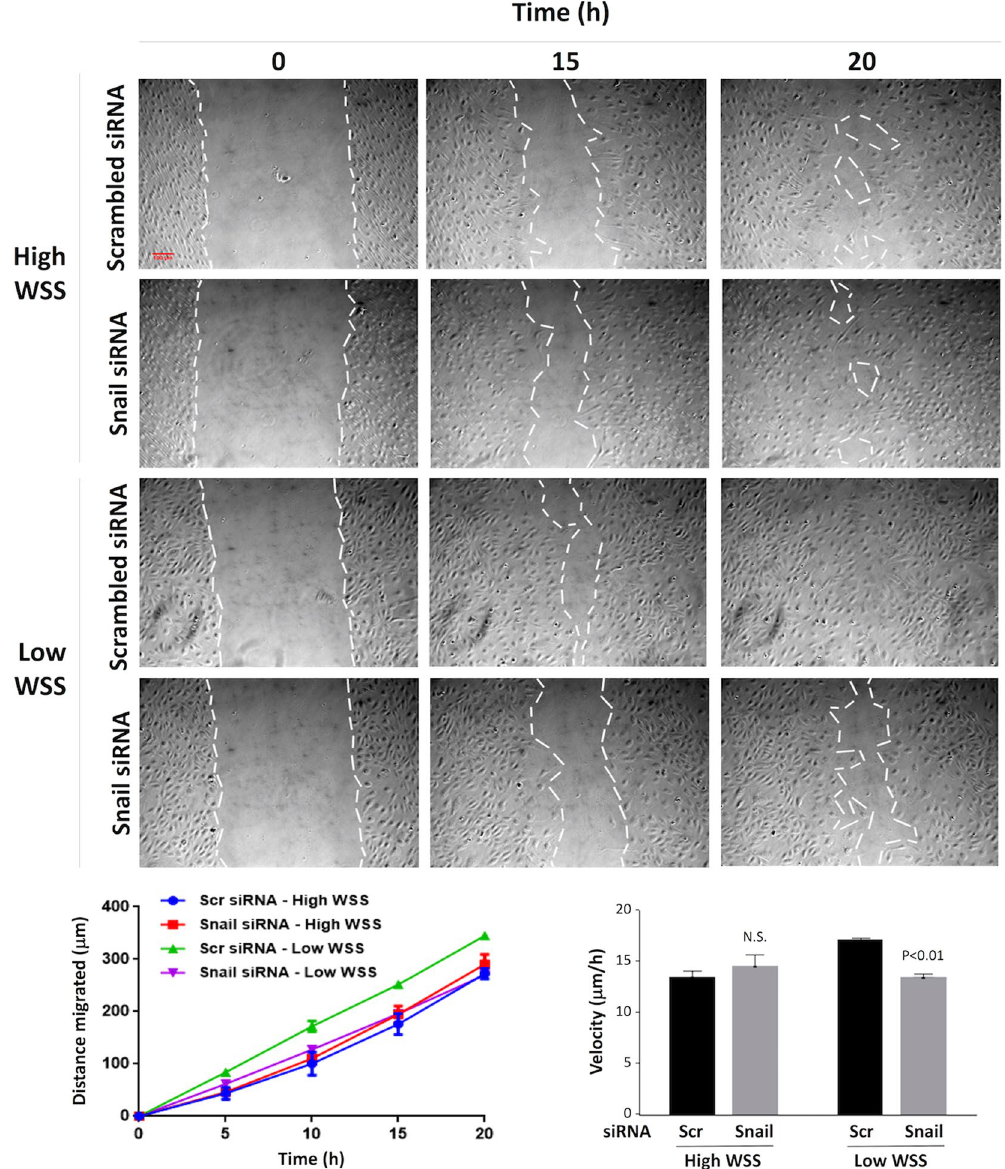
Figure 2. Snail enhanced migration under low shear stress. HUVEC were treated with siRNA targeting Snail, or with scrambled non-targeting siRNA (or were untreated as a control). They were then cultured in 6 well plates prior to exposure to low or high wall shear stress (WSS) for 72 h using an orbital plate system. To assess cell migration, a scratch wound was made in the monolayer, and cells were imaged for 20 h. Representative images are shown (scale bar 100 μ m). The distance migrated at multiple time points (lower left) and average velocity (lower right) was determined and mean values + / − SEM are shown. Data were pooled from four independent experiments using cells from different donors and mean levels + / − SEM are shown. Differences between means were assessed using a two-way